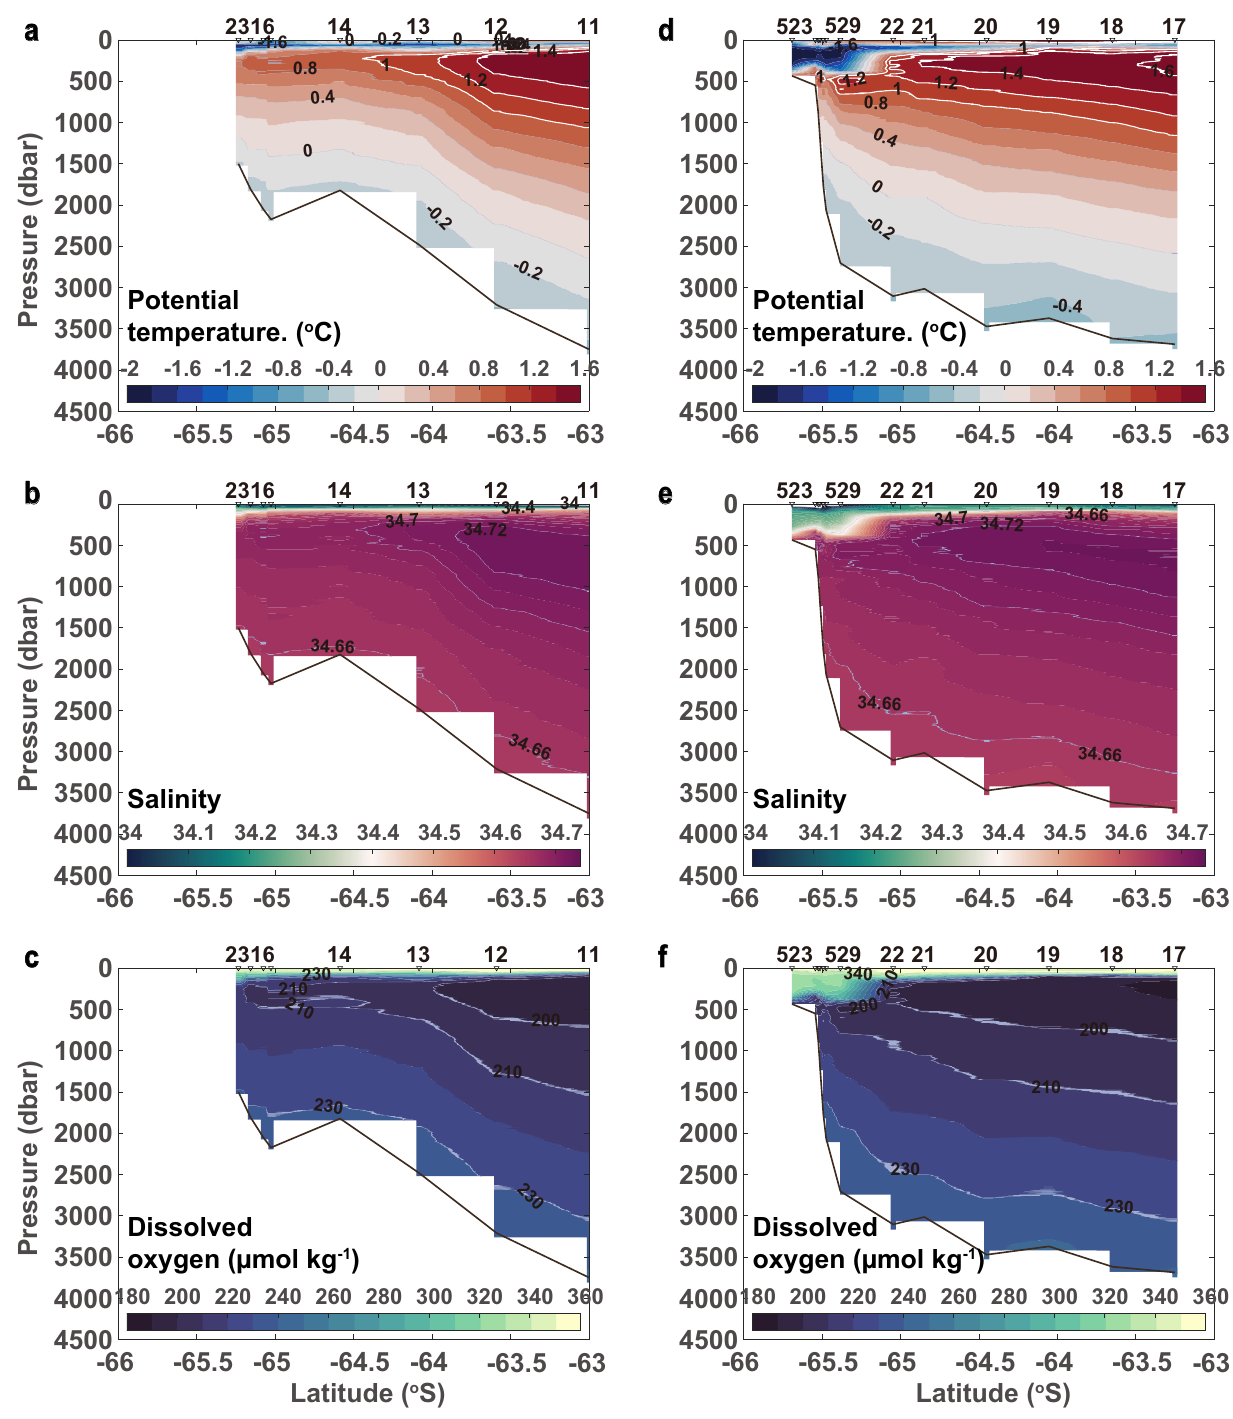
Fig. 4 Meridional warm water distribution at eddy ’ s eastern/western edges. Meridional sections along the western (Section 2, panels a – c ) and eastern (Section 3, panels d – f ) limbs of the cyclonic eddies. a , d Potential temperature (°C), b , e salinity, and c , f dissolved oxygen ( μ mol kg − 1 ). In panels a and d , potential temperatures warmer than 1 °C are highlighted with white contours. Note that the observation dates of Section 3 stations were set apart: Sta. 17 – 22 (early January 2019) and Sta. 523 – 529 (late February